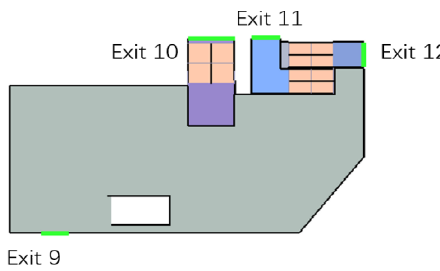
Figure 1. Surface model of the sunken square.